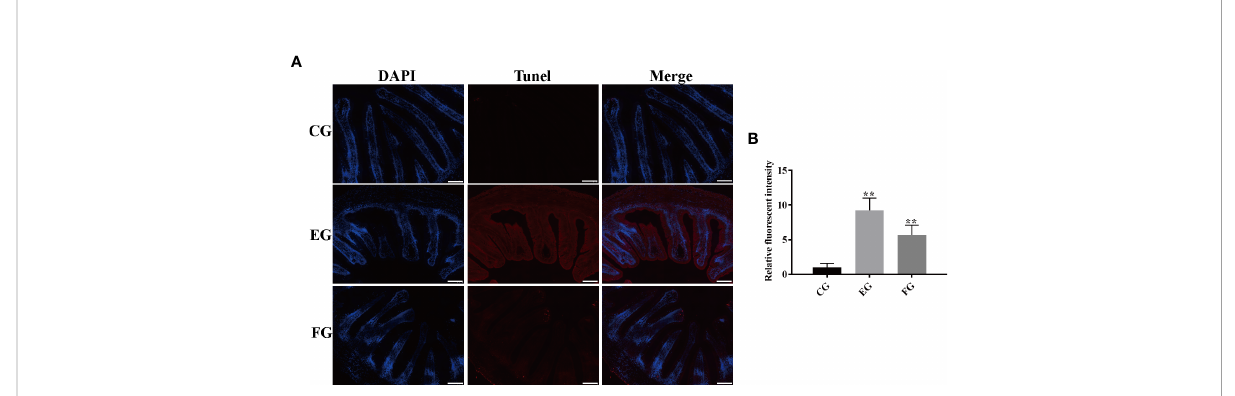
FIGURE 9 Antibiotics induced apoptosis in the midgut tissues of grass carp fed with different treatments (control (CG), enro fl oxacin (EG) and fl orfenicol (FG)) after two weeks. (A) TUNEL staining showing apoptosis in red fl uorescence after antibiotic treatments. Scale bar, 100 m m. (B) Mean fl uorescence intensity based on the TUNEL signal in EG and FG, compared with CG (**p <